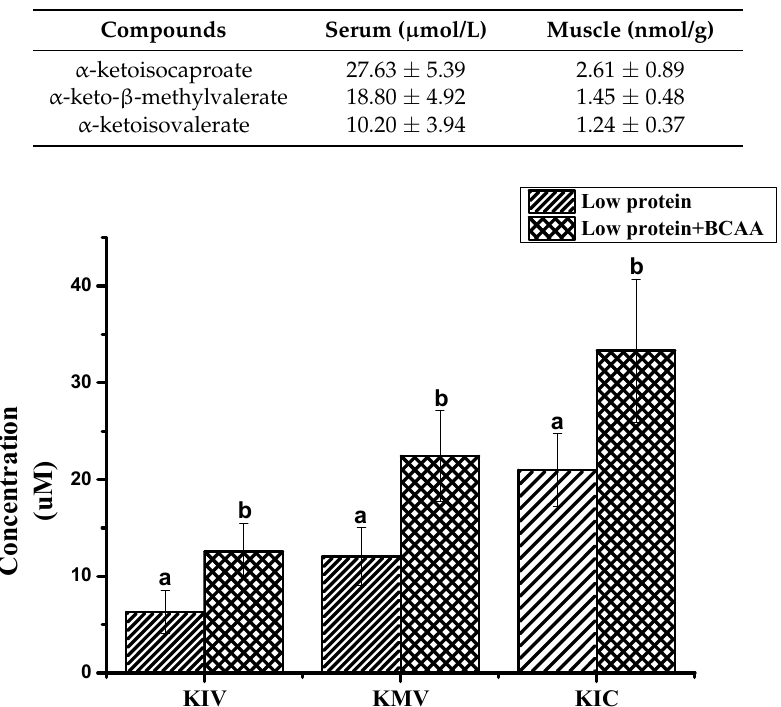
Figure 6. The influence of the addition of BCAA on the concentration of three BCKAs in serum of pigs fed different levels of dietary BCAA (KIV: α -ketoisovalerate; KMV: ketoisoleucine; KIC: α -ketoisocaproate). a , b Means the same compounds different significantly ( p < 0.05).